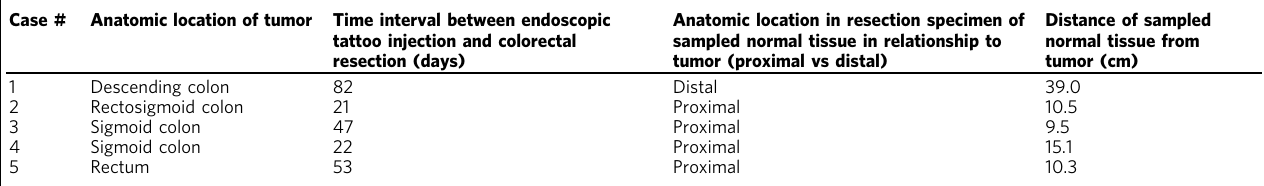
Table 1 Pathologic data for colon resection